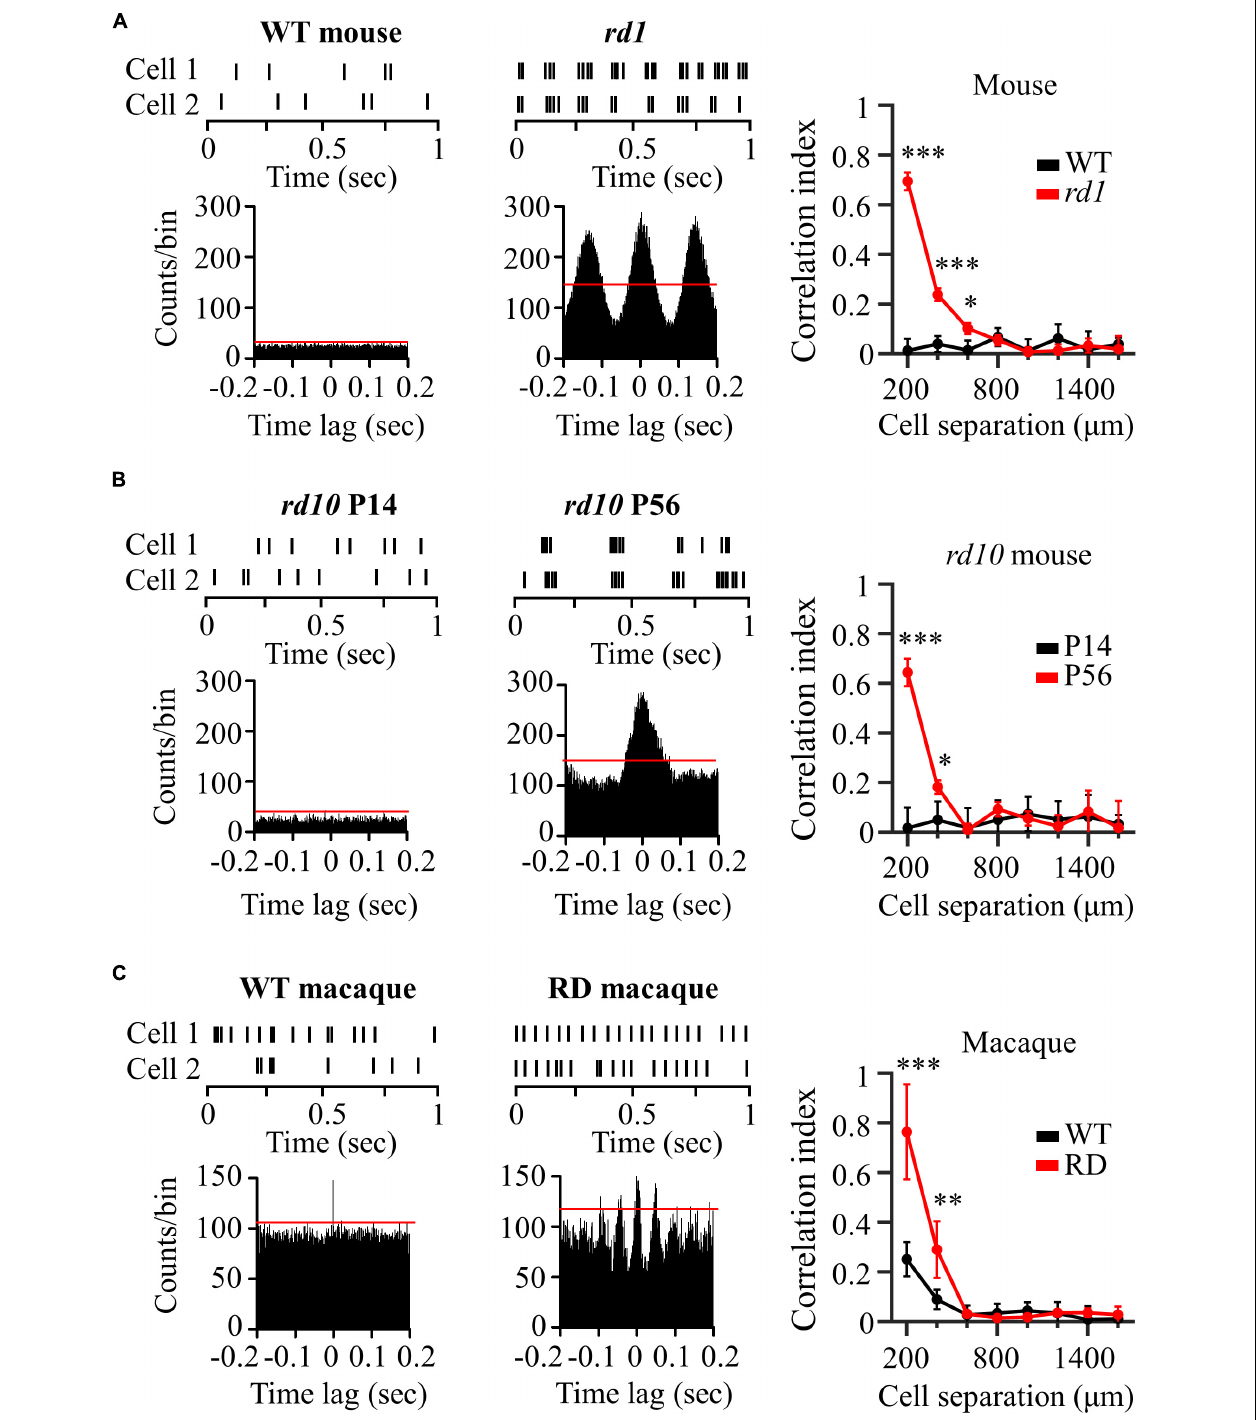
FIGURE 2 | Degenerate RGCs showed more synchronized firing patterns. (A) Cross-correlation between two RGCs in wild-type and rd1 retinas. Top left panel: raster plot of wild-type RGCs with 200 µ m spacing on the MEA. Lower left panel: cross-correlogram between RGC pairs. The time bin of the histogram is chosen to be 2 ms. The red line indicates the significance level, indicated by the 99% confidence limit of the time histogram. Top middle panel: raster plot of rd1 RGCs. Lower middle panel: cross-correlogram for rd1 . Right panel: Cross-correlation index (CCI) as a function of inter-RGC distance. The time lag is chosen to be 0.2 s. Statistical differences between wild-type and rd1 mice are indicated by asterisks (*** p < 0.001, ** p < 0.01, * p < 0.05). (B) Cross-correlation between two RGCs in rd10 P14 and rd10 P56. (C) Cross-correlation between two RGCs in wild-type and RD macaque.